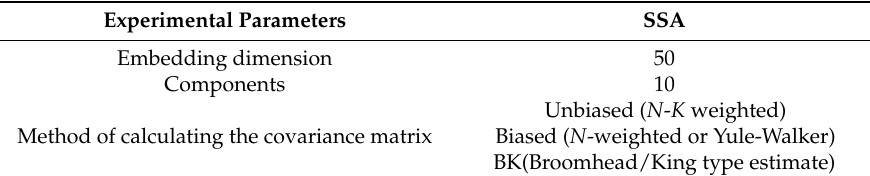
Table 6. The experimental parameters of singular spectrum analysis